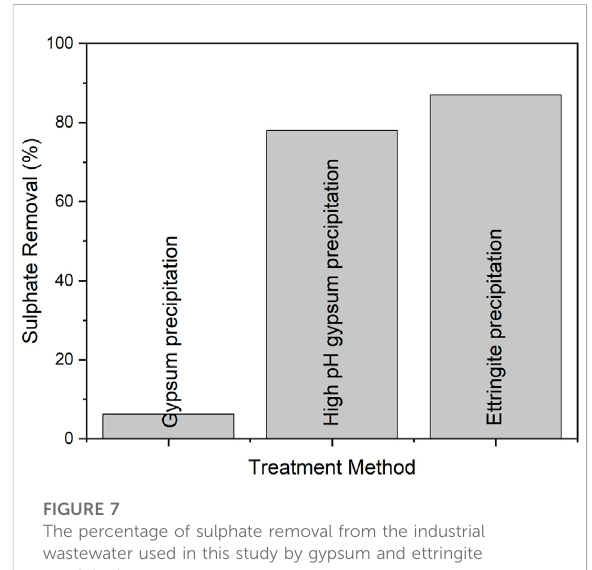
FIGURE 7 The percentage of sulphate removal from the industrial wastewater used in this study by gypsum and ettringite